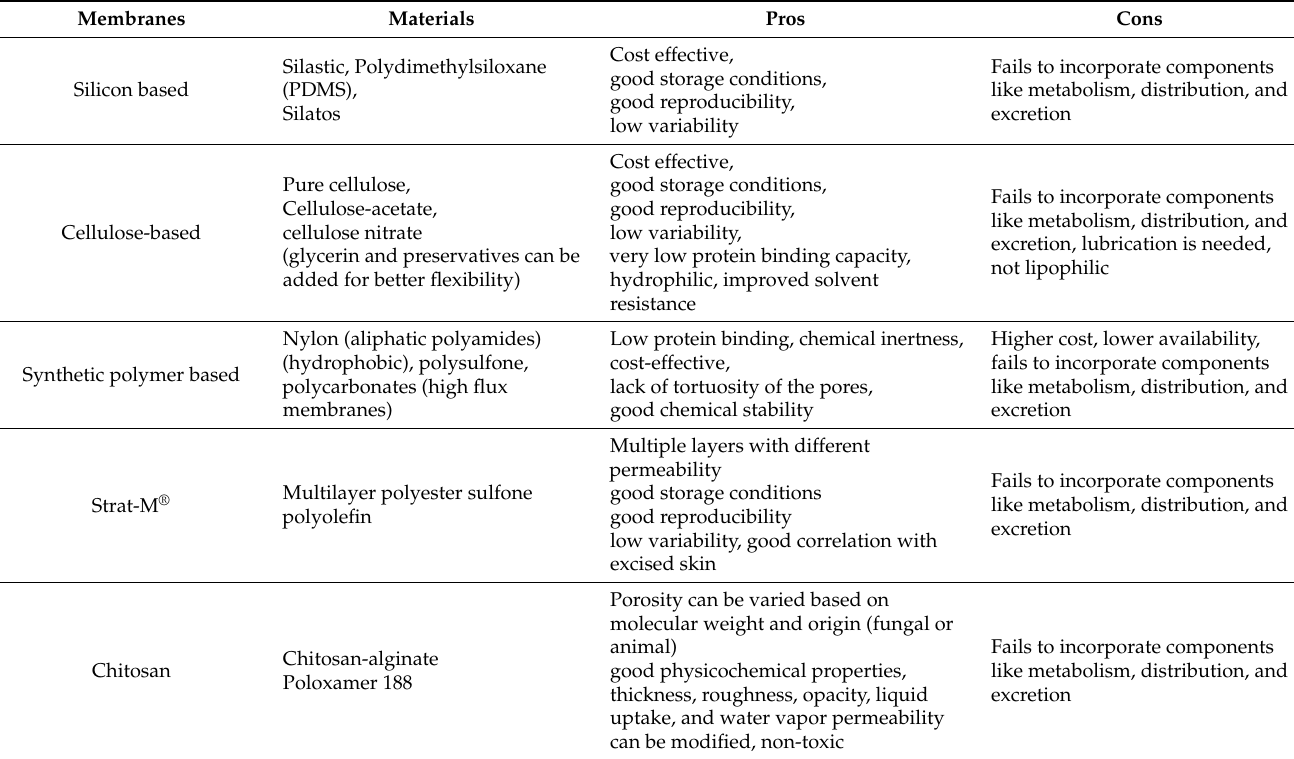
Table 1. Membranes used in diffusion studies as a surrogate of excised skins